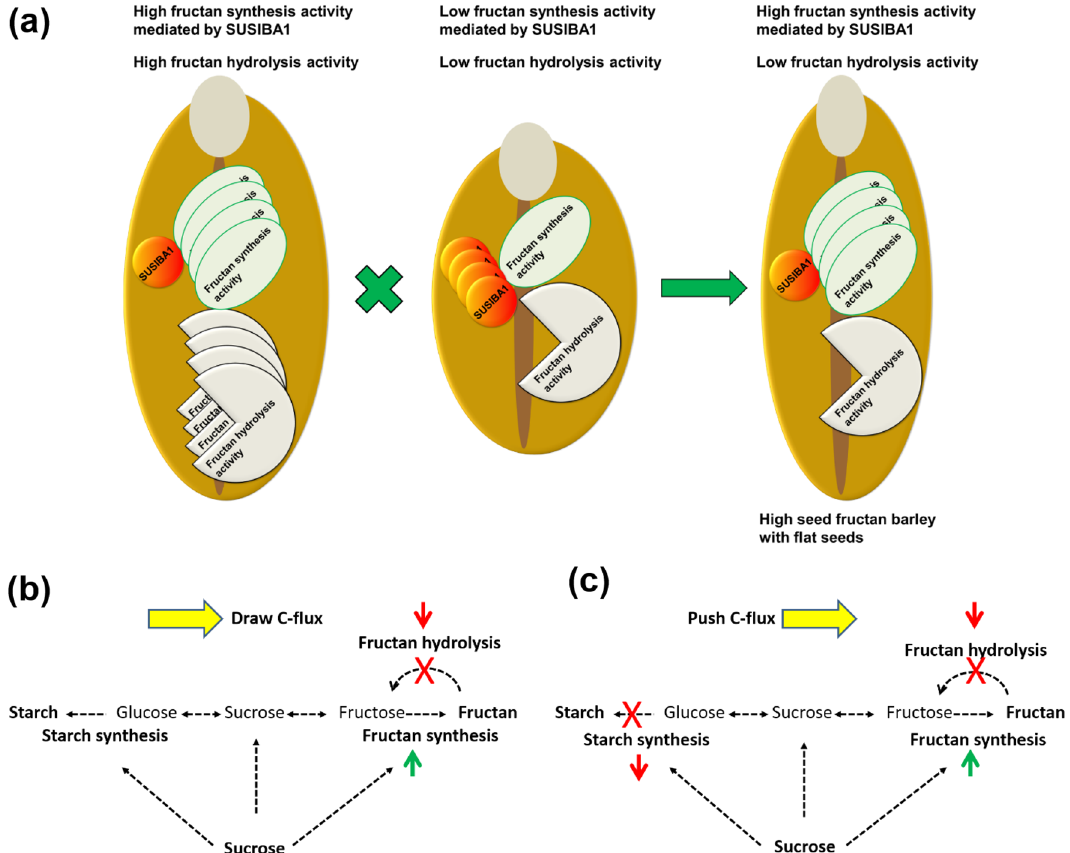
Figure 7. Model depicting the crossing strategy in this study to obtain high grain fructan barley and mechanism in determining grain fructan content at harvesting. ( a ) The red disc represents negative transcription factor SUSIBA1 for fructan synthesis. Fructan synthesis activity as indicated represents at least activity of 6-SFT and 1-SST. Fructan hydrolysis activity consists at least of 6-FEH and 1-FEH. Less SUSIBA1 leads to more fructan synthesis activity. High grain fructan barley usually has a flat grain phenotype. ( b ) Lower fructan hydrolysis activity (pull marker) together with the higher fructan synthesis activity (push maker) generates a force for carbon-flux to fructan accumulation without impacting starch synthesis. ( c ) Starch synthesis is disrupted by mutations, which generates a high concentration of small sugars pushing carbo-flux to fructan synthesis accompanied with lower fructan hydrolysis and higher fructan synthesis Barley crossing was performed according to Poehlman and Sleper 28 . and the detail crossing strategy was described in Fig. 1. Briefly, 224 (G3) was used as maternal to do cross with 199 (G1) and 155 (G2), and 199 (G1) as maternal to do cross with 235 (G3). After crossing, 20 plants of each crossing line, as F1 generation, were cultivated, and for F2 and F3 generations, 50 plants of each crossing line were cultivated respectively, to check the segregation and select high fructan plants. Based on the results we found in this paper, flat seed is correlated with high fructan. After three-generation screening, the F 3 progenies of barley lines with unique flat seeds were defined with high fructan lines and used for further experiments. The F 4 grain was used for a small field trial and the F 5 grain was used for yield assessment. Field trials were performed in 2018 and 2019, respectively. In 2018, area with 20 m 2 was separated into four independent field blocks of around 4 m 2 per block, at a site (59.8222° N, 17.6593° E) near Uppsala, Sweden. Three replicates of three barley lines of F4 generation (224 × 155, 224 × 199, 199 × 235) and their parents (155, 199, 224, 235) were randomly distributed in the four blocks. Harvested grains were stored dry at room temperature for dif- ferent experiments. In 2019, A large field trial was performed by Lantmännen at Bjertorp, Sweden, 355 km from Uppsala, to test yield. Trial seeds (F 5 ) were multiplied in New Zealand. Two plots of 15 m 2 per plot size were used for three cross lines (224 × 155, 224 × 199, 199 × 235). Two elite barley varieties, one six-row barley Aino approved in Norway and one two-row barley Anneli on the Swedish market were included in the yield assessment. Primers. Primers were listed in Supplementary Table S2.